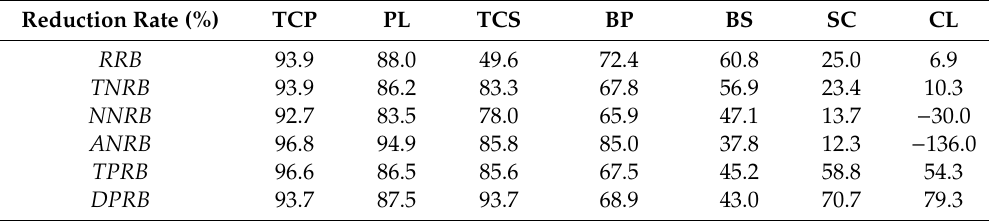
Table 4. Relationship between cumulative runo ff and sediment yield under di ff erent crop types. Reduction Rate (%) TCP PL